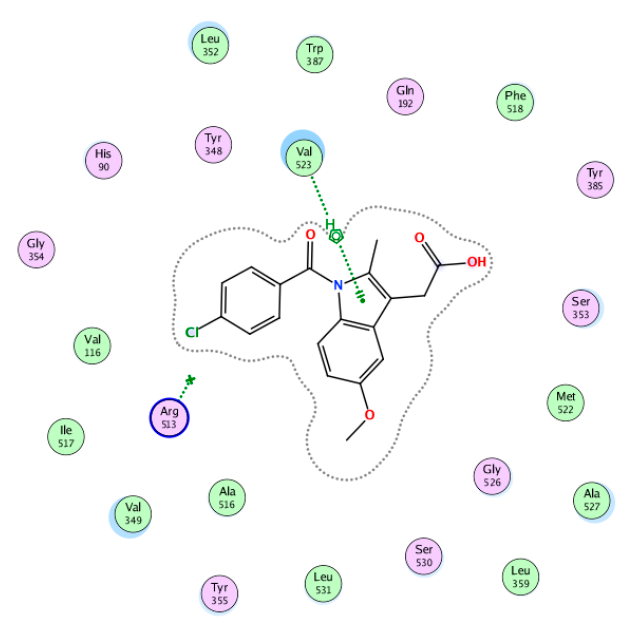
Figure 4. Interaction of indomethacin with COX-2 protein.